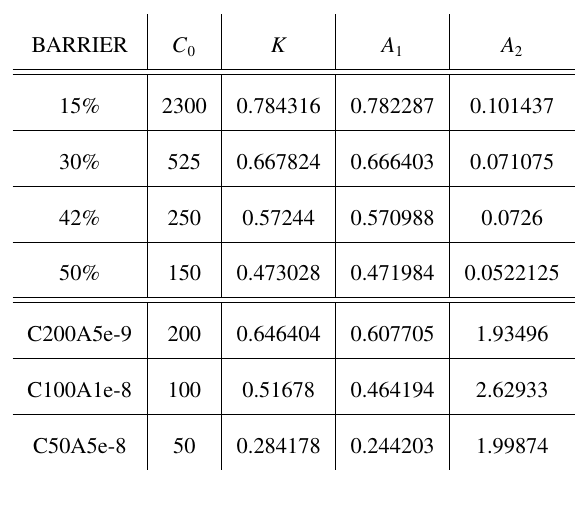
Table 1. Koe ffi cients for the quadratic estimation of the force (15) acting on the barrier (fence) with given parameters.